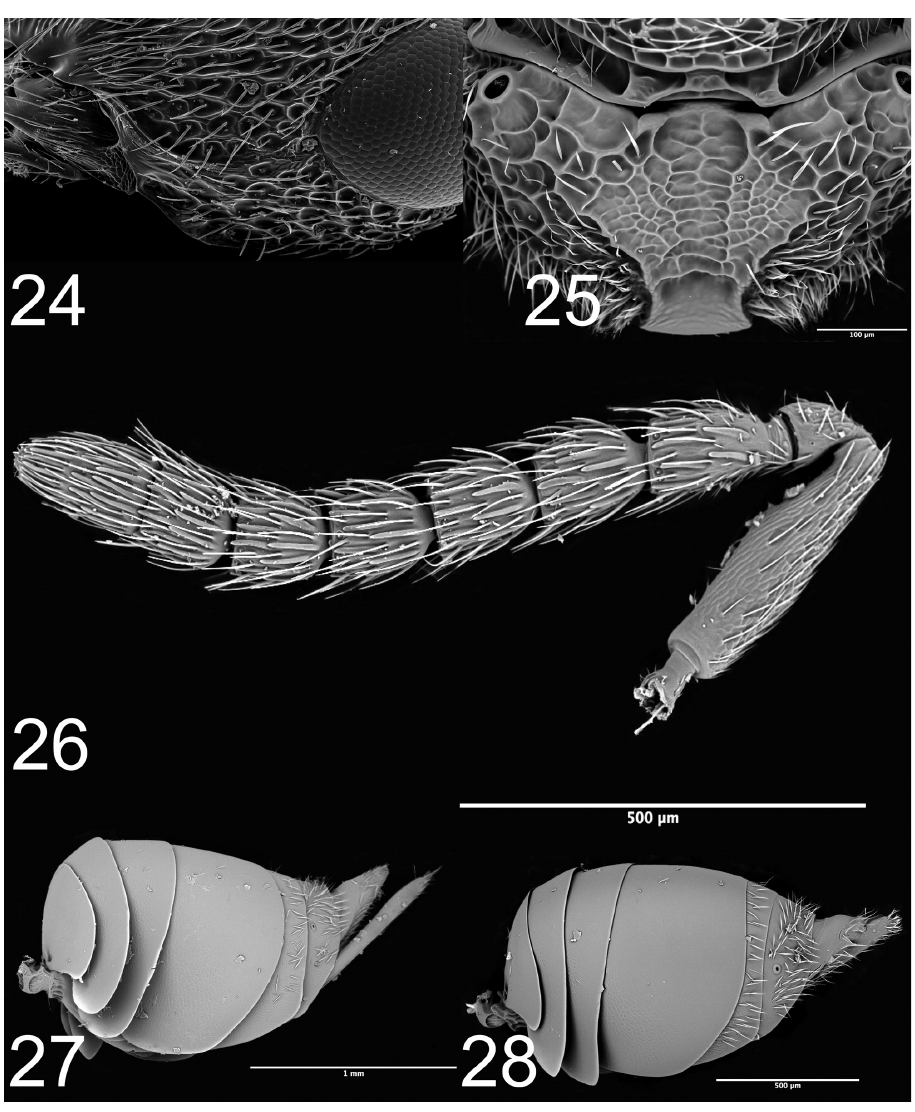
Figure 24–28. Eurytoma shorthousei 24 Face in lateral view. E. longavena 25 Propodeum 28 Female metasoma, lateral view. E. discordans 26 Female antenna 27 Female metasoma.